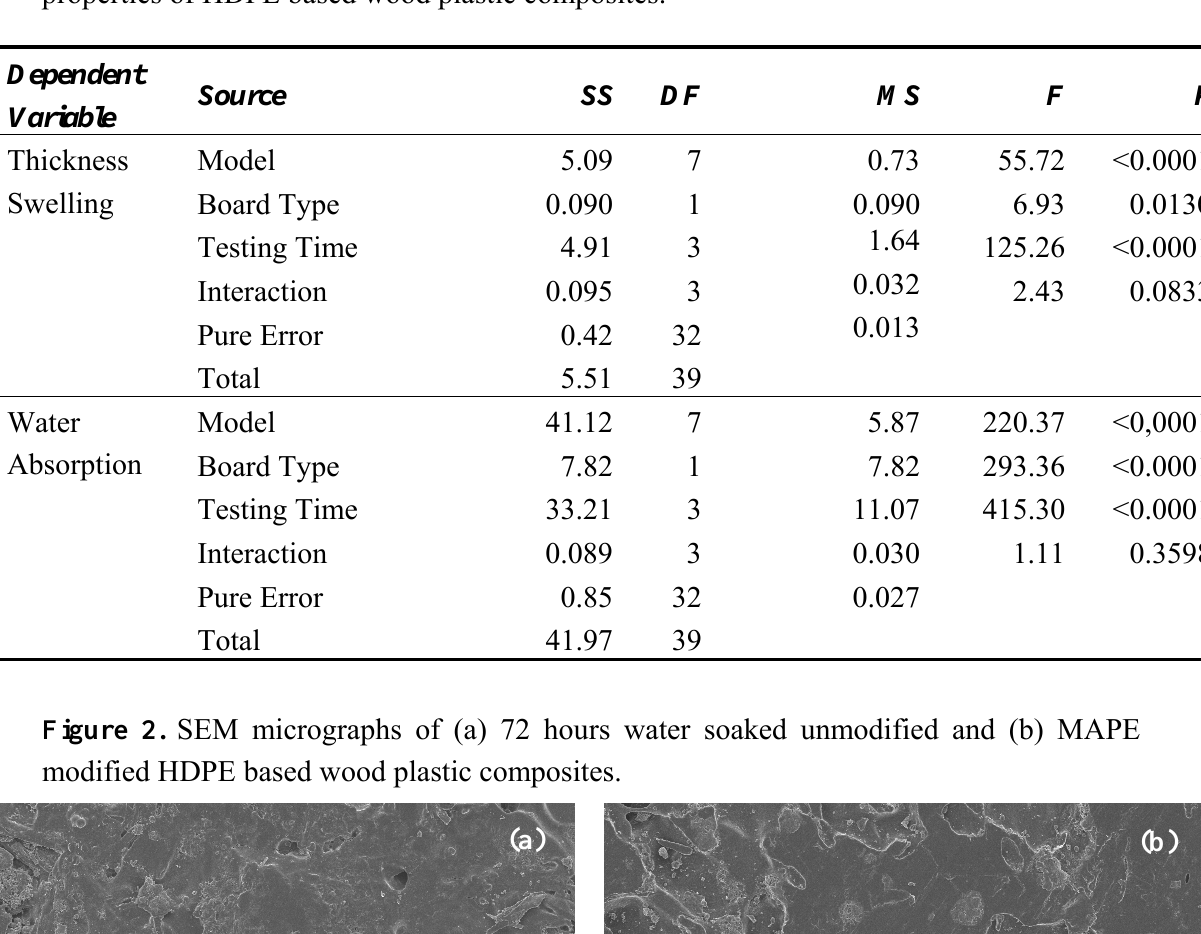
Table 5 . Analysis of variance (ANOVA) for thickness swelling - water absorption properties of HDPE based wood plastic composites.